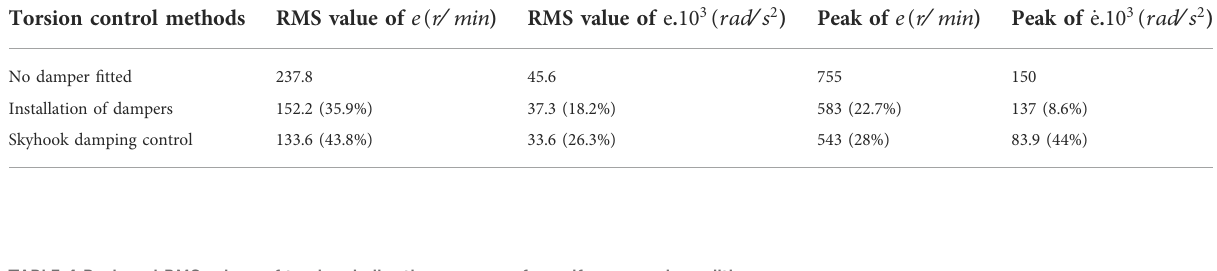
TABLE 3 Peak and RMS values of torsional vibration response for acceleration condition.